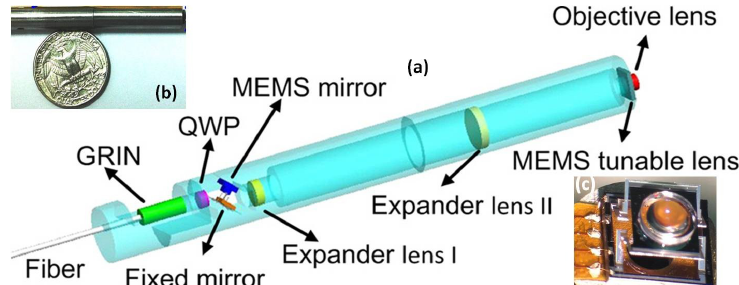
Figure 8. Electrothermal MEMS scanner-based confocal microendoscope. ( a ) Schematic 3D drawing of the microendoscope design. ( b ) Photograph of the assembled microendoscopic probe with US coin as a reference. ( c ) Photograph of an assembled tunable lens on the electrothermal MEMS scanner. Reproduced with permission from [45]; published by Elsevier, 2014.